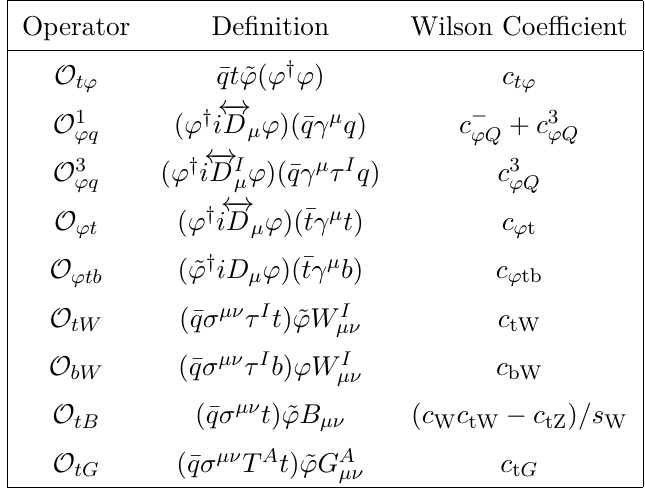
Table 1 . The operators and corresponding Wilson coefficients considered in this paper. Left- handed fermion doublets are denoted by q , and right-handed fermion singlets by t and b ; the Higgs doublet is denoted by ϕ . The antisymmetric SU(2) tensor is denoted by ε ≡ iτ 2 . Furthermore, ←→ ←→ ˜ ϕ = εϕ ∗ , ( ϕ † i D µ ϕ ) ≡ ϕ † ( iD µ ϕ ) − ( iD µ ϕ † ) ϕ , and ( ϕ † i D I ϕ ) ≡ ϕ † τ I ( iD µ ϕ ) − ( iD µ ϕ † ) τ I ϕ , where µ τ I are the Pauli matrices. Finally, T A ≡ λ A / 2 , where λ A are Gell-Mann matrices. The covariant derivative is D = ∂ = ∂ + g , 1 A ABC G B λ A G A − ig 1 τ I W I − ig 0 Y B µ , and G A − ∂ ν G A G C µ µ − ig s µ G s f µ µ µν ν µ µ ν 2 2 = ∂ + g(cid:15) , and B = ∂ are the gauge field strength I J W I − ∂ ν W I W K µ W IJK W µν µ B ν − ∂ ν B µ µν ν µ µ ν